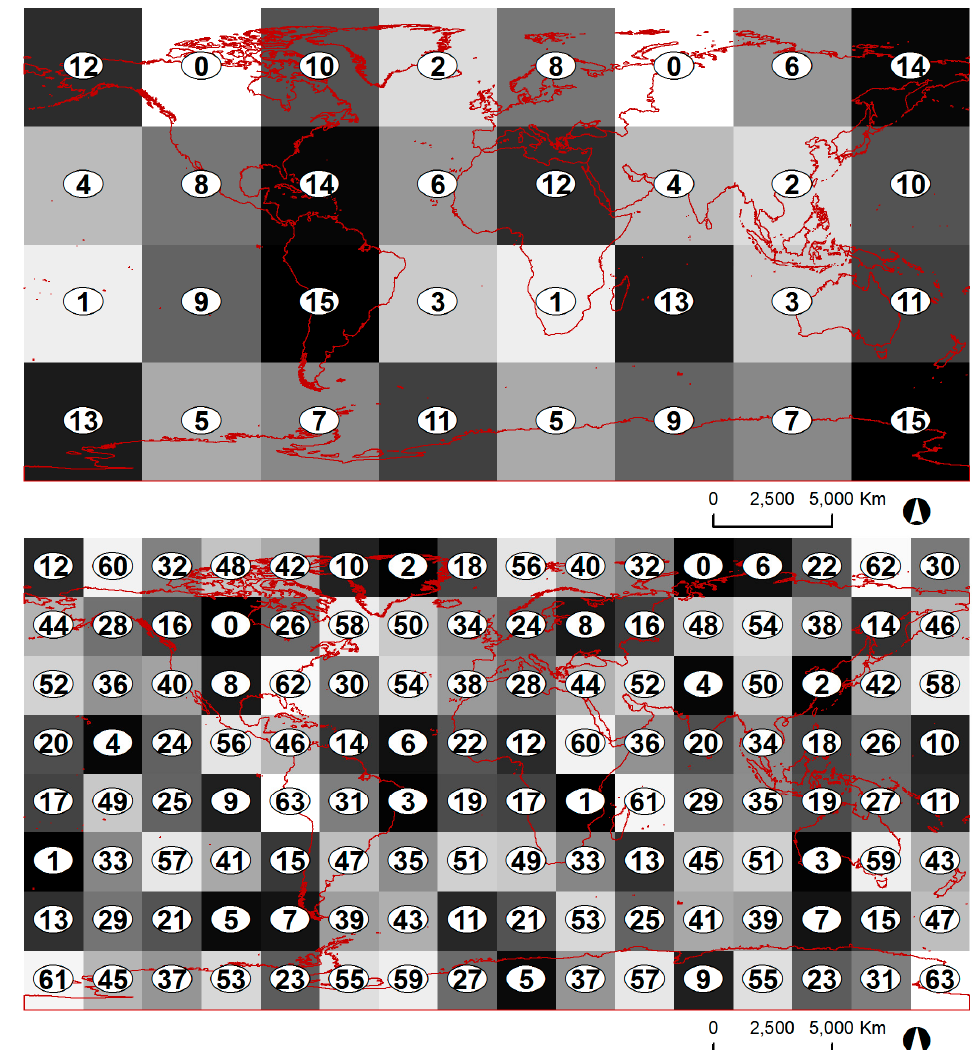
Figure 1. The global sampling design strategy is hierarchical, multi-scalar, and comprehensive, which provides a tessellation of cells and a sampling order that maintains spatial balance. The first level ( L ) of the global grid ( GG 1 ) both the eastern and western hemisphere has cells of 90° on a side in the sequence 0, 1, 2, 3 (northwest, southwest, northeast, southeast). GG 2 (top) has 16 cells of 45° on a side, while GG 3 (bottom) has 32 cells of 22.5°. Note that the GG L+ 1 raster is nested within the GG L so that the sequence numbers follow.